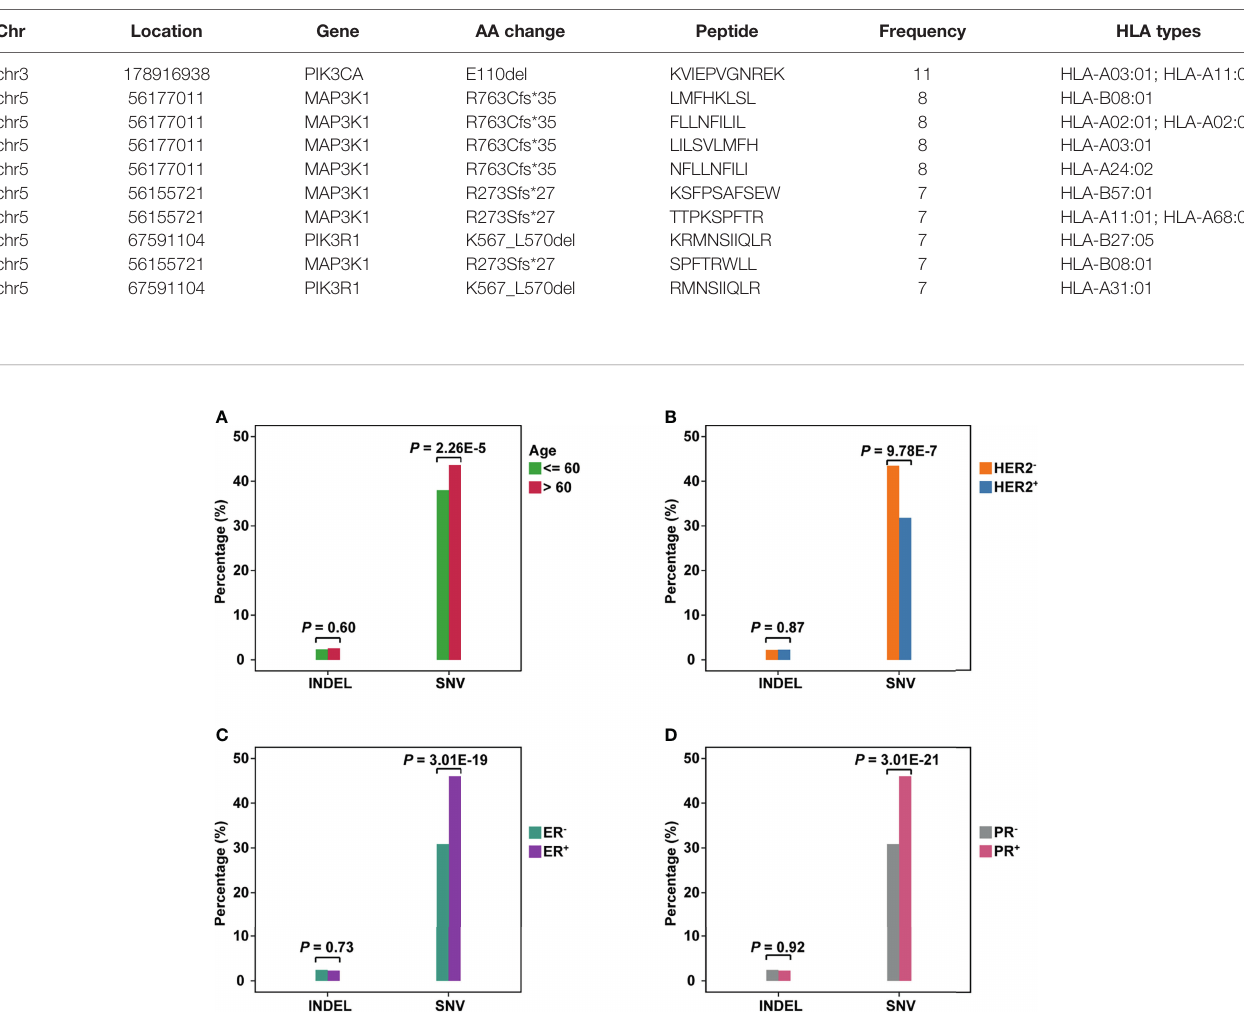
TABLE 2 | Top 10 indels and corresponding